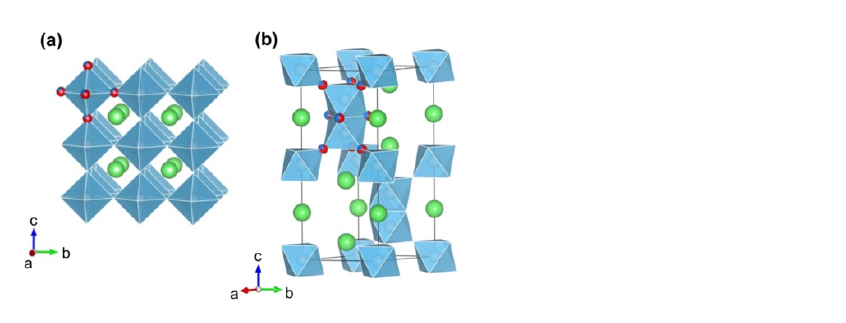
Figure 1. Comparison of the crystal structures of ( a ) 3C-BaTiO 3 and ( b ) 6H-BaTiO 3 . The green, gray, red, and blue balls represent Ba, Ti, O, and H atoms, respectively.